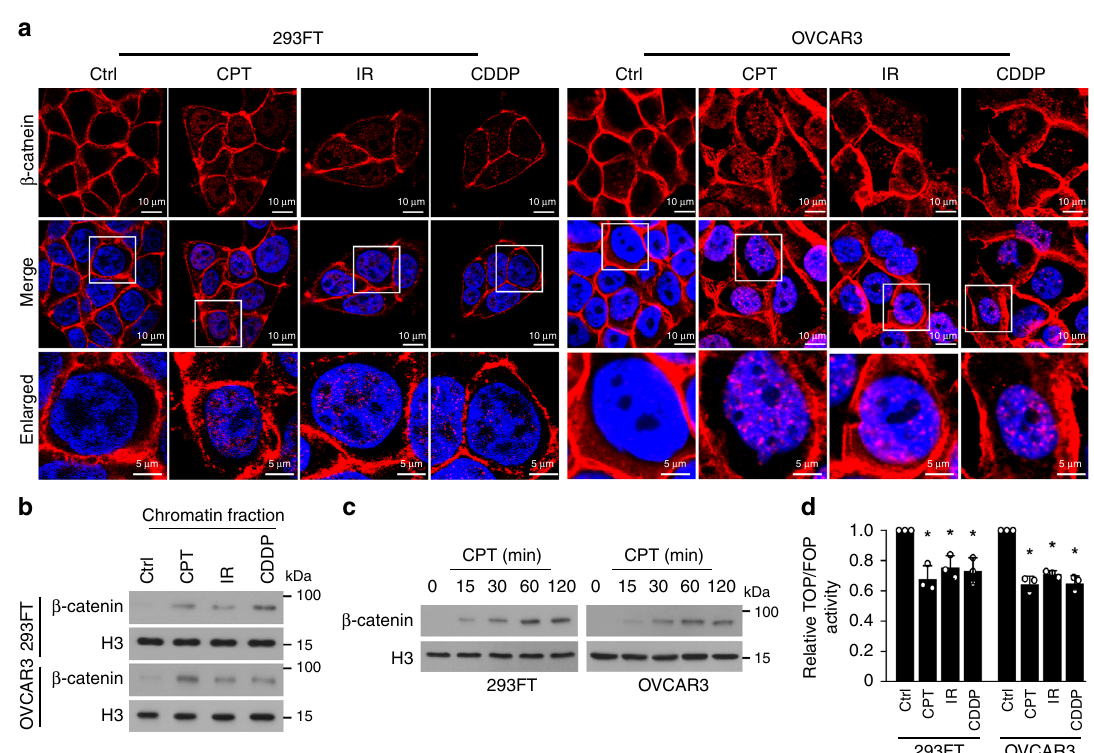
Fig. 1 Genotoxic stress-induced β -catenin signaling is activated via a TCF- or FOXO-independent mechanism. a Representative images of the subcellular localization of β -catenin in the indicated cells treated with CPT (10 μ M, 1 h), IR (10 Gy), and CDDP (10 μ M, 1 h), as analyzed by immuno fl uorescence staining. Scale bar, upper and middle panel: 10 μ m; lower panel: 5 μ m. b IB analysis of expression of β -catenin expression in the chromatin fraction extracted from the indicated cells treated with CPT (10 μ M, 1 h), IR (10 Gy), and CDDP (10 μ M, 1 h). Histone 3 served as the loading control. c IB analysis of β -catenin expression in the chromatin fraction extracted from the indicated cells treated with CPT (10 μ M) for 0, 15, 30, 60, and 120 min. Histone 3 served as the loading control. d Relative TOP fl ash or FOP fl ash luciferase reporter activity was analyzed in the indicated cells treated with CPT (10 μ M, 1 h), IR (10 Gy), and CDDP (10 μ M, 1 h). Each error bar represents the mean ± SD of three independent experiments. * P < 0.05. Student ’ s two-tailed t test. Source data of Fig. 1d are provided as a Source Data fi LEF1, TCF3(TCF7L1), and TCF4 (TCF7L2), had no effects on the